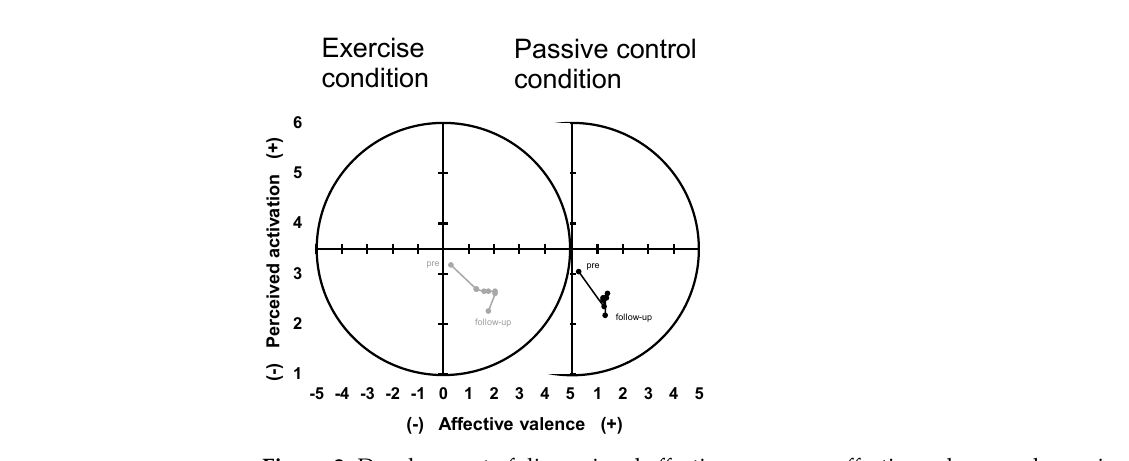
Figure 2. Development of dimensional affective responses affective valence and perceived activation over time in the exercise condition (left panel, grey dots/line) and the passive control condi- tion (right panel, black dots/line). Dots represent mean values averaged for each time point. 3.3. Rotated Dimensional Affective Responses A significant condition by time interaction emerged for the dimension energetic arousal ( F (2, 44) = 3.77, p = 0.031, η p ² = 0.15) (Figure 3). Simple contrasts showed a signifi- cantly larger pre–post increase in energetic arousal in the exercise condition compared to the control condition ( p = 0.012, η p ² = 0.25) but no significantly different pre–follow-up change between conditions ( p = 0.093, η p ² = 0.12). No significant condition by time inter- action was found for the dimension tense arousal ( F (2, 44) = 1.09, p = 0.345, η p ² = 0.05). A significant main effect of time was found both for dimension energetic arousal ( F (2, 44) = 4.96, p = 0.011, η p ² = 0.18) and tense arousal ( F (2, 44) = 18.65, p < 0.001, η p ² = 0.46). On average, energetic arousal significantly increased from pre to post ( p = 0.045, η p ² = 0.17) and from pre to follow-up ( p = 0.008, η p ² = 0.28). Tense arousal significantly decreased from pre to post ( p < 0.001, η p ² = 0.46) and from pre to follow-up ( p < 0.001, η p ² = 0.61). No